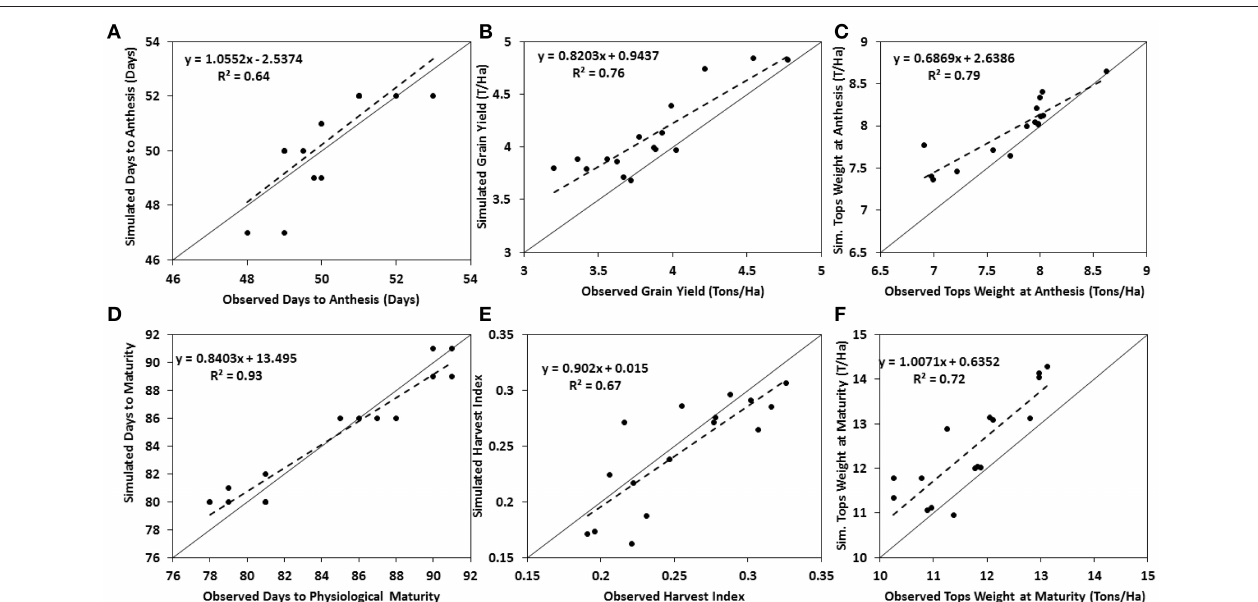
FIGURE 3 | Comparisons of observed and simulated variables for the calibration of TZEE. Solid lines represent 1:1 relationships, dashed line represents linear regression, and each point represents a plot for both dry and rainy seasons. (A) Days to Anthesis; (B) Grain Yield, (C) Tops Weight at Anthesis, (D) Days to Physiological maturity, (E) Harvest Index, and (F) Tops Weight at Maturity.